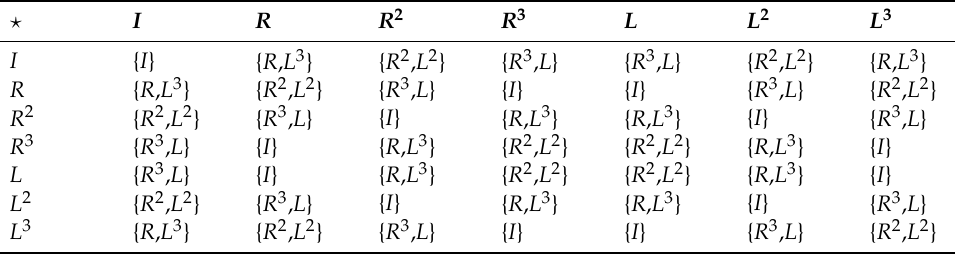
Figure 1. Square π . Table 6. The binary hyperoperation ⋆ on M .